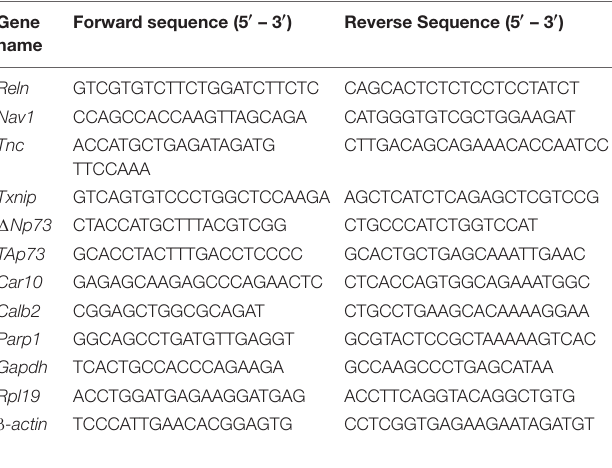
TABLE 1 | Sequences of primers used for quantitative